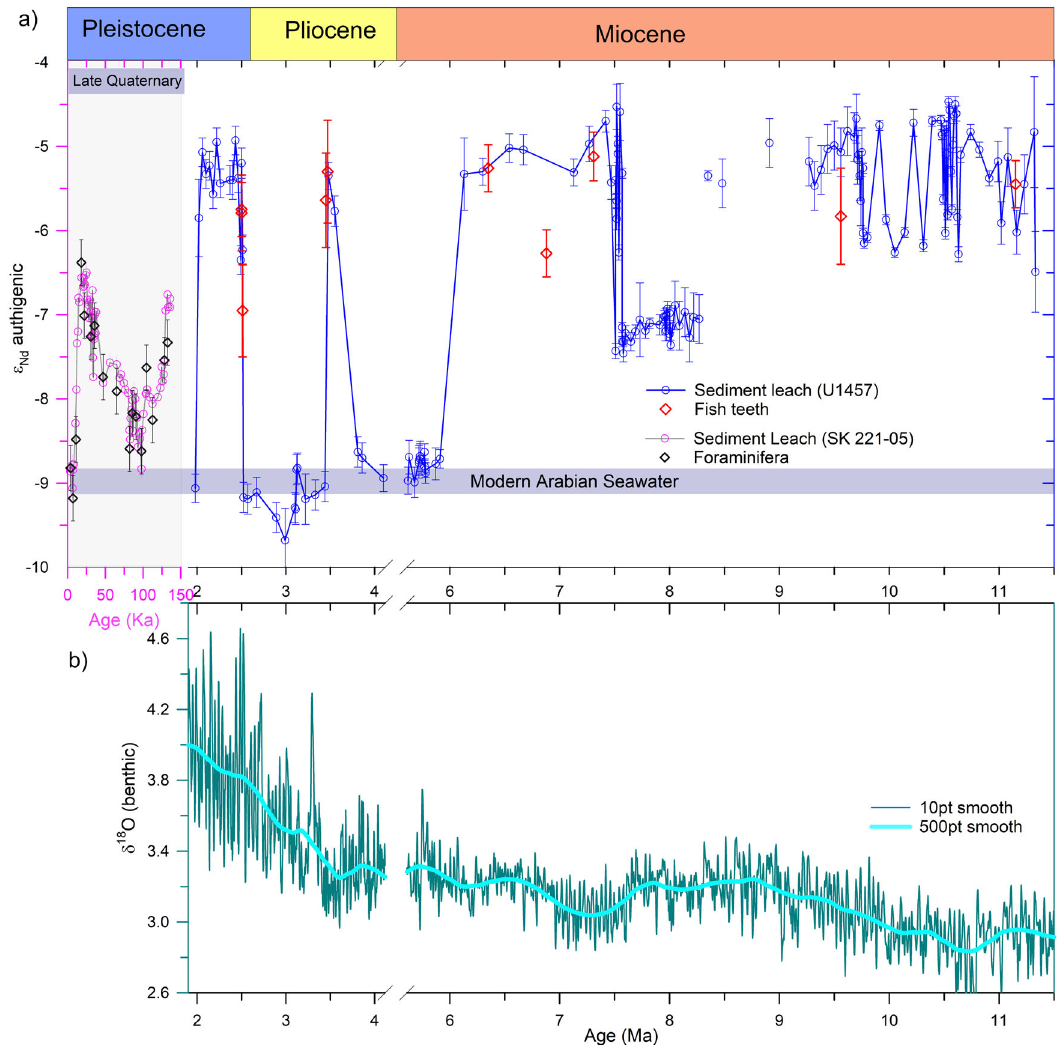
Fig. 2 | Authigenic and detrital ε Nd records from the Arabian Sea. a Authigenic ε Nd record of site U1457 (water depth 3522m) covering a time span of 1.9 (blueline),thelateQuaternaryrecord(pinkline)isfromsiteSK221-05(waterdepth